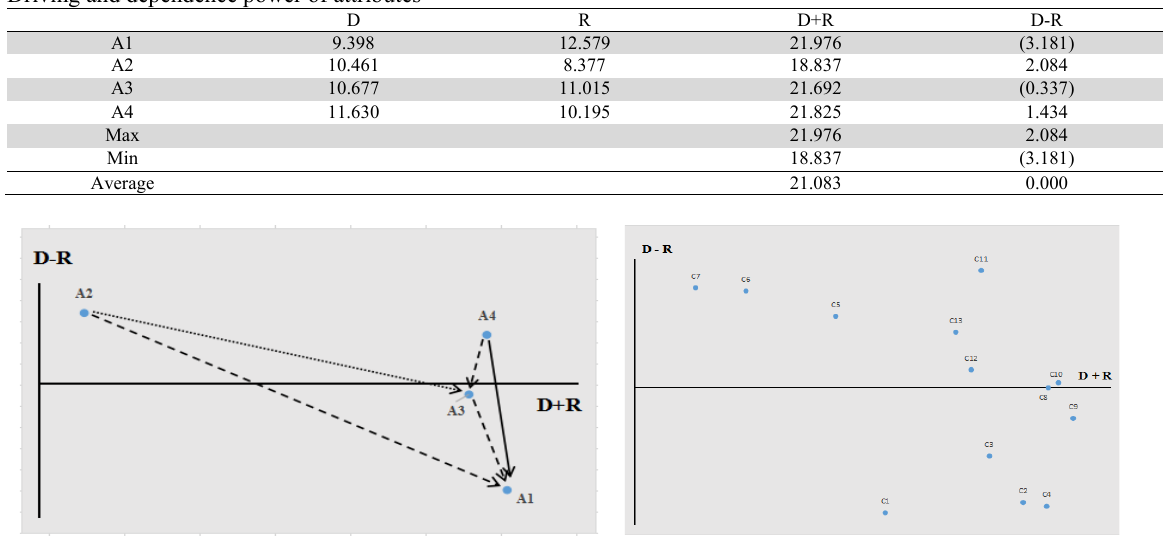
Driving and dependence power of attributes